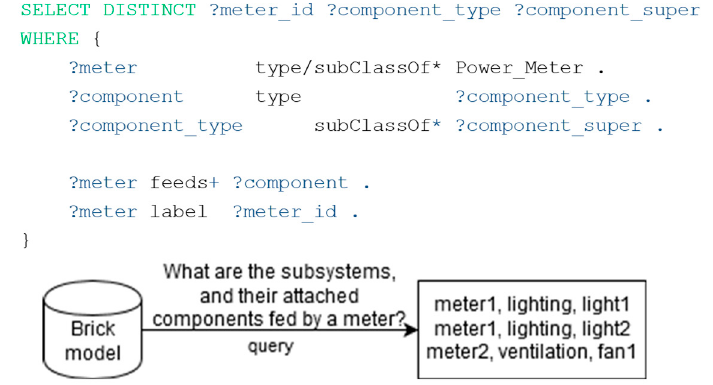
Figure 3. On the left, a SPARQL query for collecting enough information to construct a mapping from meter to sets of component types (and their chain of superclasses) fed by that meter. An illustration of the query question and example results on the right.